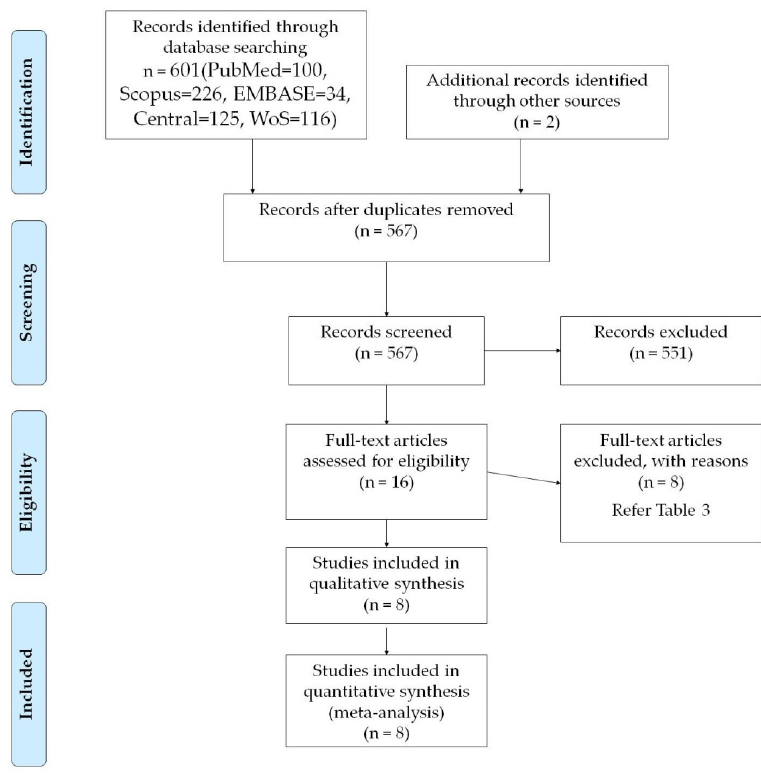
Figure 1. PRISMA—flow chart for study selection.